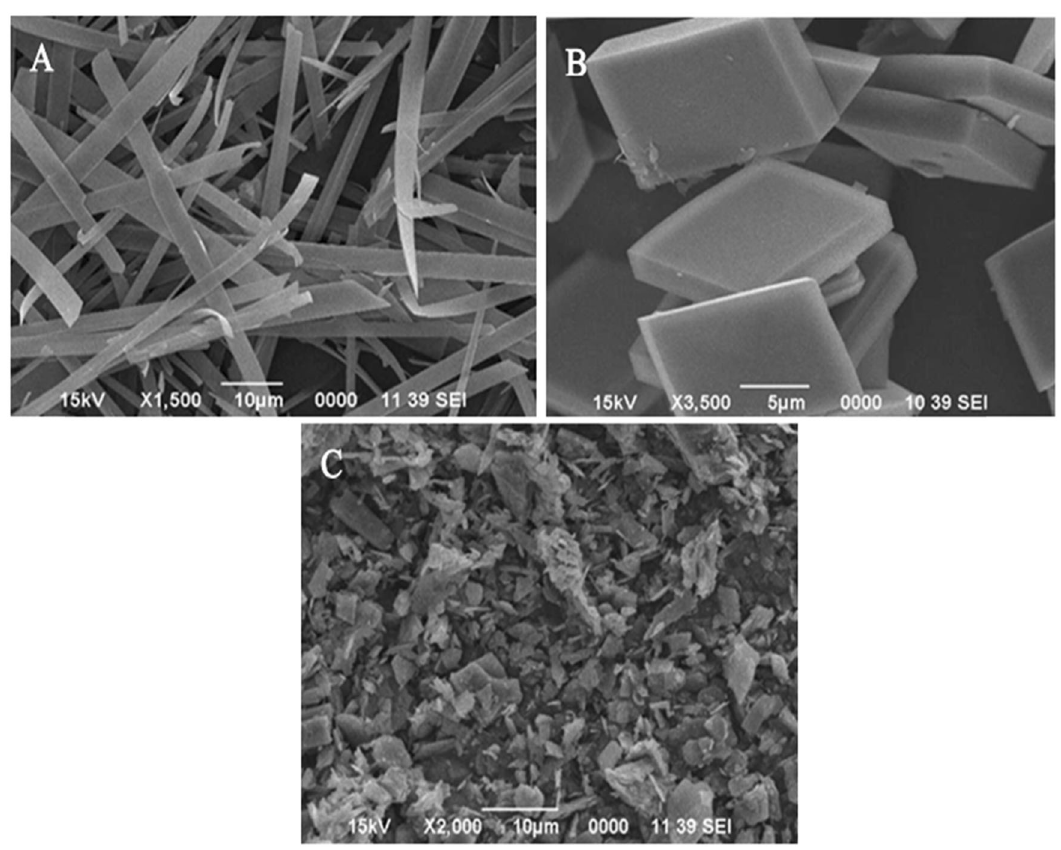
Fig. 1 SEM analysis of the reactant solutions heated at 85 °C containing 0.4 M urea, 0.05 M Ca(NO 3 ) 2 , and 0.1 M NaH 2 PO 4 aged for ( A ) 30 and ( B ) 50 min, particles formed were immersed in 0.1 M NaOH solution for 30 min at 60 °C ( C ) commercial